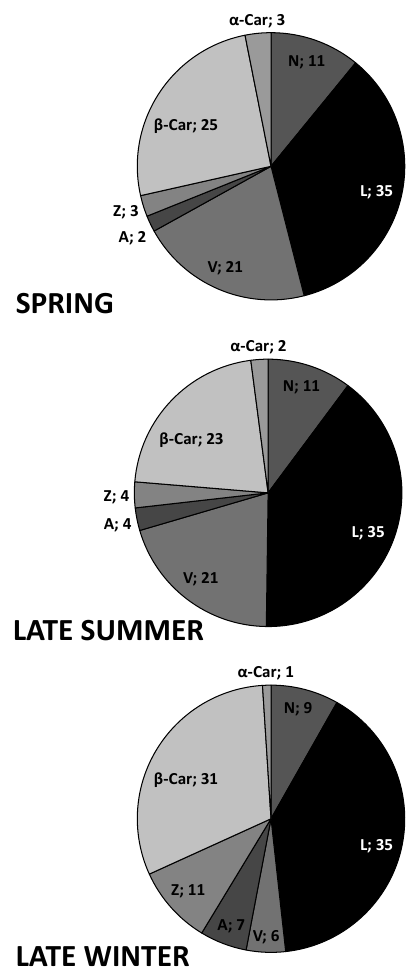
Figure 7. Composition of each carotenoids (N, Neoxanthin; L, Lutein; V, Violaxanthin; A, Anteraxanthin; Z, Zeaxanthin, β -Car, β -Carotene and α -Car, α -Carotene) in percentage in spring, late summer, and late winter.